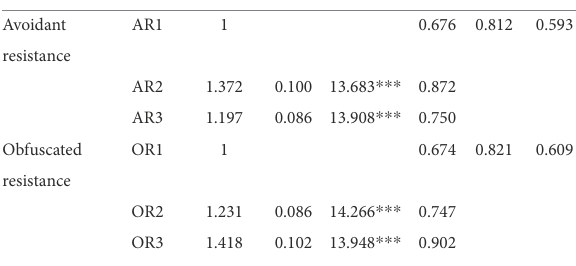
TABLE 3 Confirmatory factor analyses results ( n =